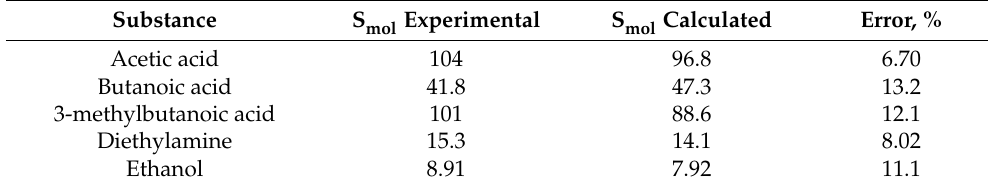
Table 8. Calculated and experimental molar-specific sensitivity (S mol ) of microweighing of VOC